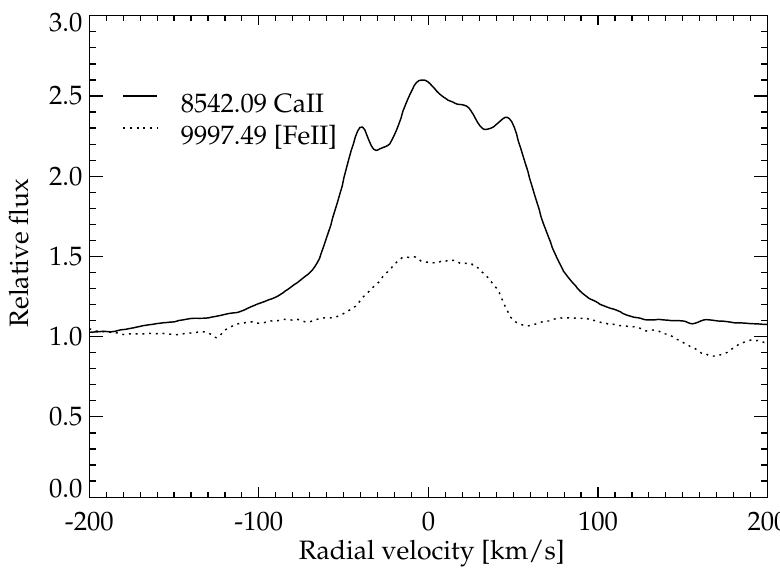
Fig. 5. Here a comparison of the [Fe II] lines and Ca II emission lines is plotted.